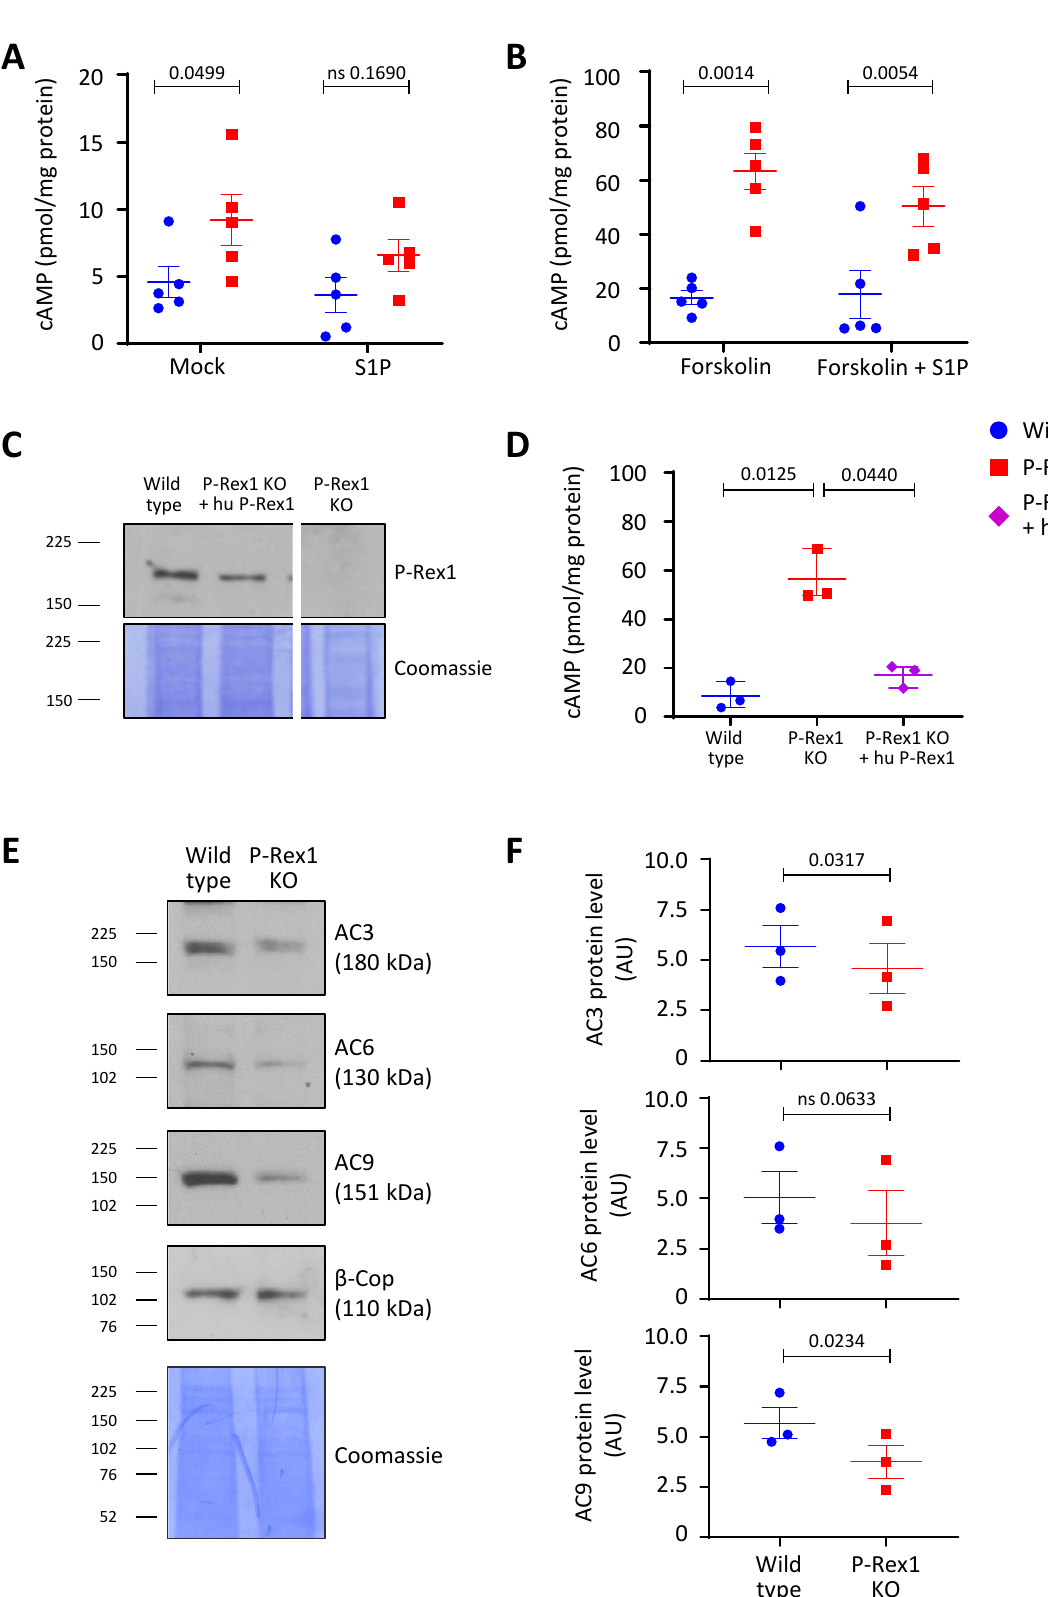
Figure 4. P-Rex1 deficiency constitutively increases cAMP levels in PC12-S1PR1 cells, while decreasing the levels of Figure 4: P-Rex1 deficiency constitutively increases cAMP levels in S1PR1-GFP PC12 cells major neuronal adenylyl cyclases. ( A , B ) P-Rex1 deficiency constitutively increases cAMP levels in PC12-S1PR1 despite reduced levels of major neuronal adenylyl cyclases